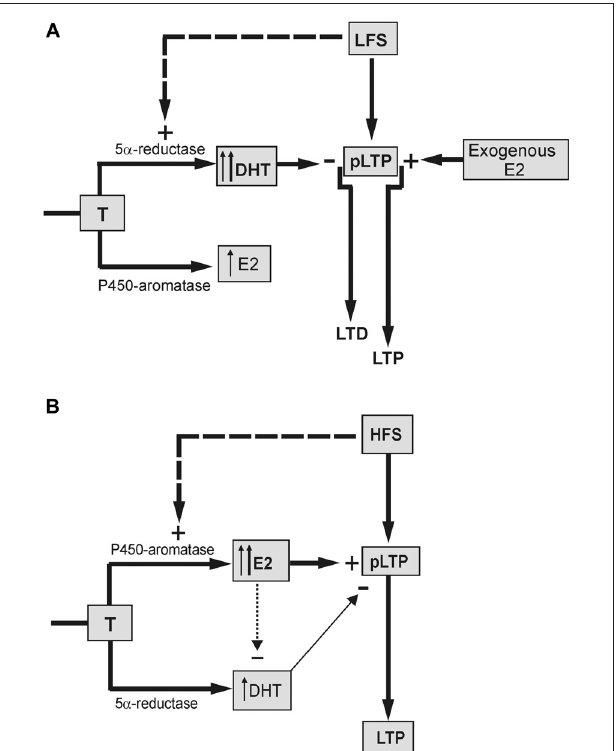
FIGURE 6 | Comparison of the responses induced by different stimulation patterns under combined blockade of E2 and DHT synthesis and under block of E2 alone. The amplitude of the responses induced by LFS, WFS, MFS and HFS are compared under FIN + LET (white columns, one-way ANOVA, F 3,27 = 3.39, Tukey’s post hoc test * p < 0.05) and under LET alone (hatched gray columns, one-way ANOVA, F 3,30 = 50.34, p < 0.0001, Tukey’s post hoc test ∗∗ p < 0.001, ∗ p < 0.05). The graph also reports the difference between the values observed under combined and single block (two headed arrow and number) for revealing the inhibitory contribution of DHT at the different stimulation frequencies. Note the progressive decrease of the DHT influence.